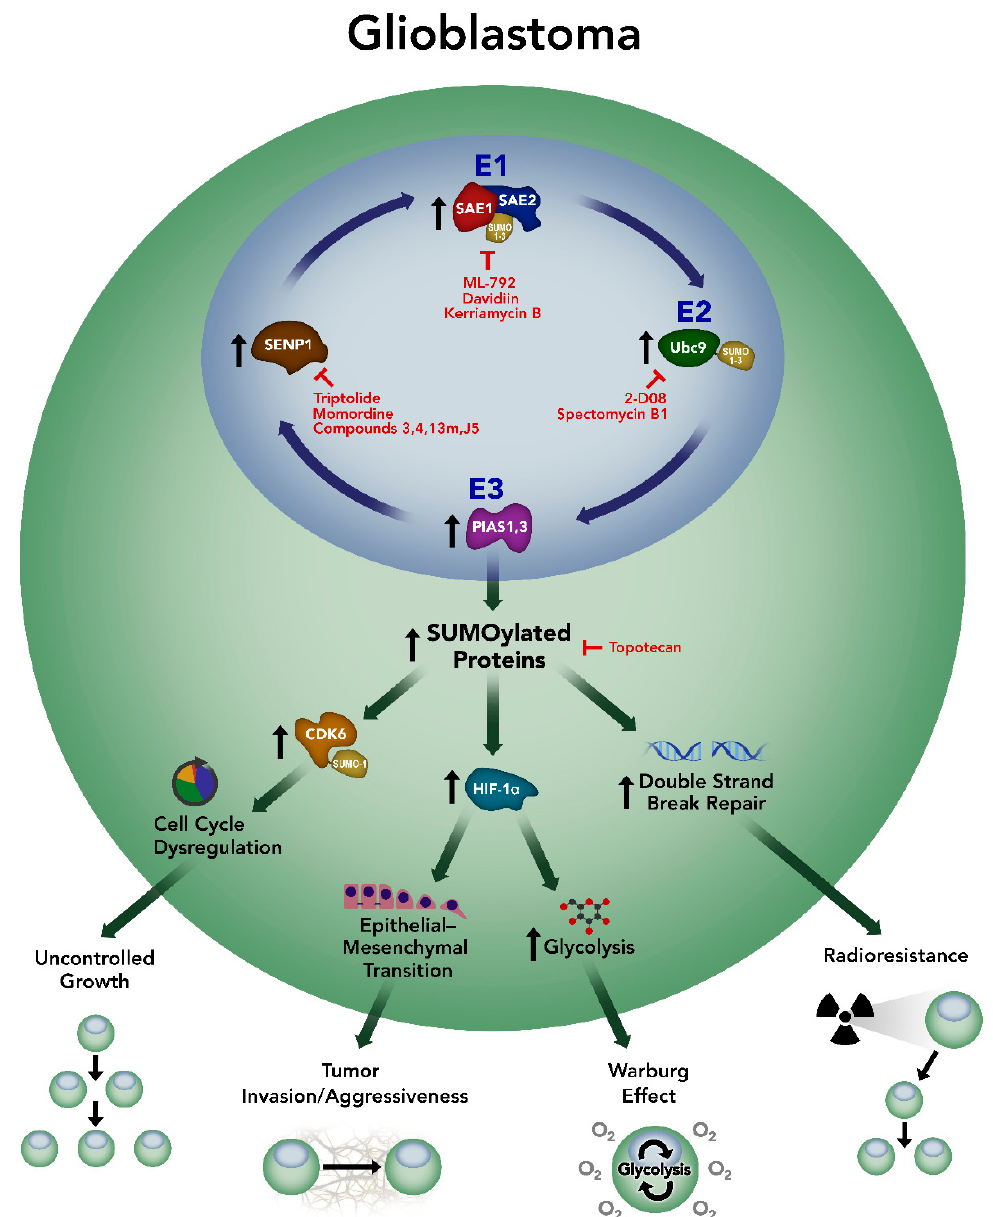
Figure 1. Enhancement of SUMOylation in glioblastoma contributes to alterations in multiple cellular processes leading to an increased malignant phenotype. Glioblastoma displays an increase in E1 (SAE1), E2 (Ubc9), and E3 (PIAS1 and PIAS3) enzymes leading to global enhancement of SUMOylation and a resultant increase in the SUMOylation level of target proteins. Further, increased expression of SUMO-specific protease (SENP1) has been reported in glioblastoma. Presently, studies have implicated CDK6 and HIF-1 α as important loci downstream of these e ff ects that together contribute to cell cycle dysregulation, epithelial-mesenchymal transition, and heightened glycolytic metabolism. DNA double-strand break repair has additionally been associated with perturbations in SUMOylation.